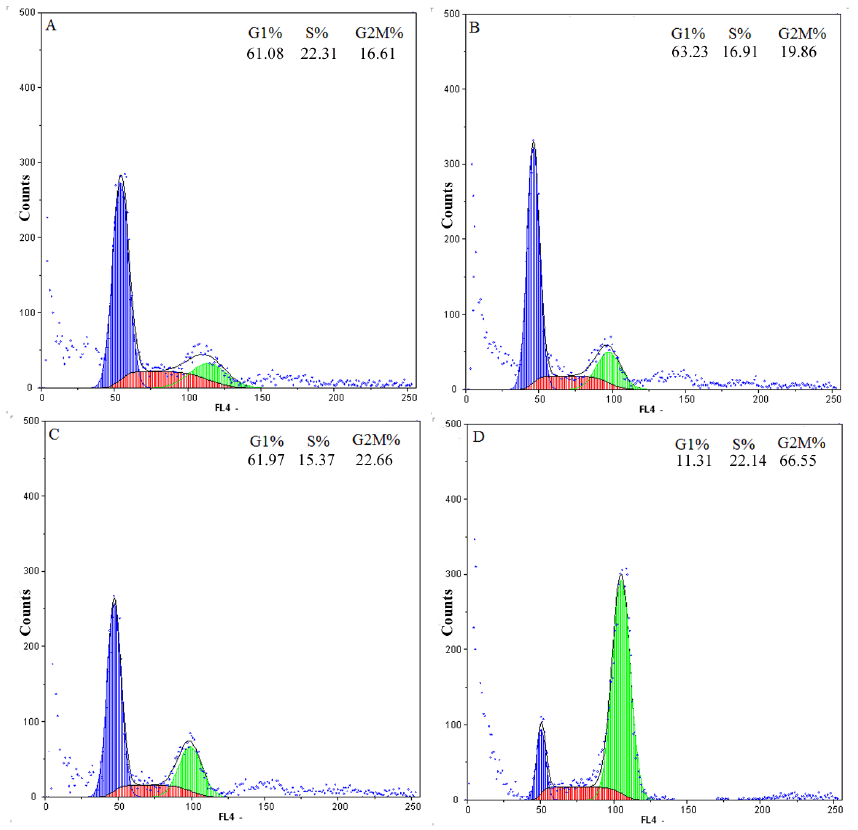
Figure 2. Cell cycle distribution of MDA-MB-231 cells after treatment with different concentrations of chamaejasmine for 48 h. ( A ), treatment with 0 μ M chamaejasmine; ( B ), treatment with 4 μ M chamaejasmine; ( C ), treatment with 8 μ M chamaejasmine; ( D ), treatment with 16 μ M chamaejasmine. Blue = G1; red = S; green = G2/M. The figure shown here are representative of three independent experiments with similar